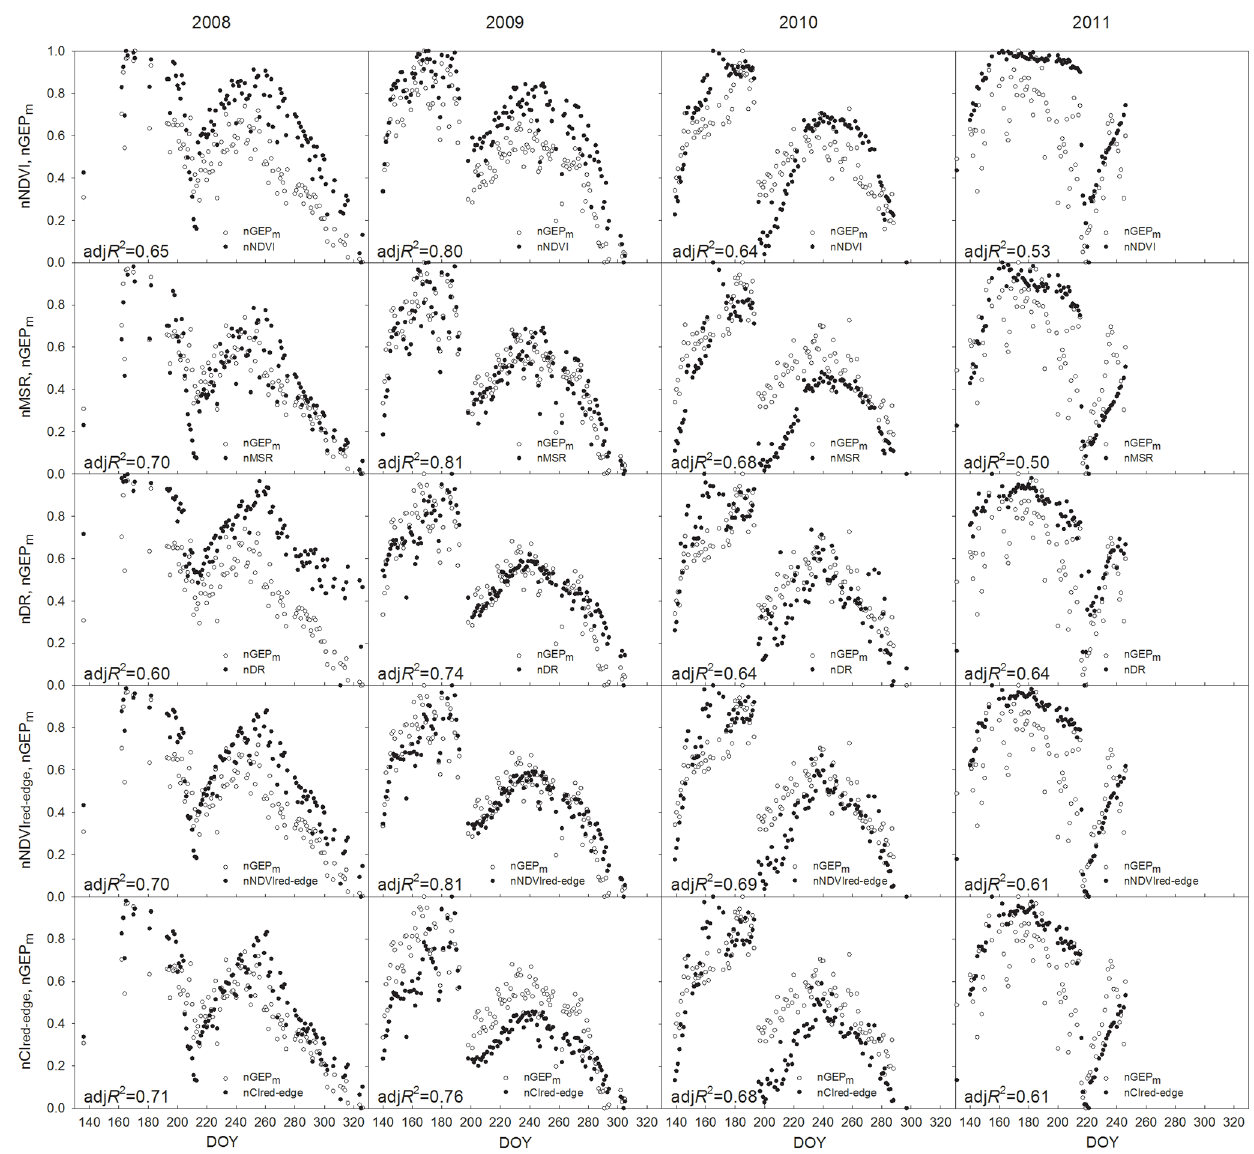
Figure B1. Seasonal courses of normalized spectral vegetation indices – nVIs (–) and normalized mean midday gross ecosystem production – nGEP m (–) in the growing seasons of 2008–2011 (columns from left to right); adj R 2 between GEP m estimated from EC measurements and GEP m obtained with model 1 fed with the various